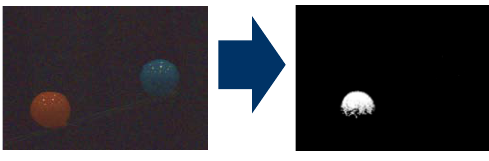
Figure 7. Red ball detection. Figure 7. Red ball